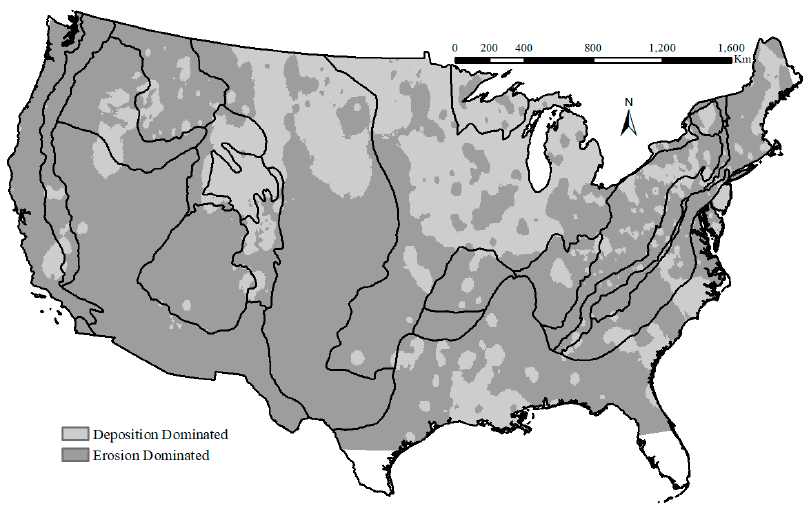
Figure 7. Spatial map showing dominant channel processes over the contiguous U.S. The map was prepared by interpolating the difference between critical and available stream power values for 1829 points.